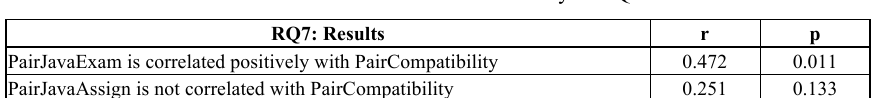
Table 12. Results summary of